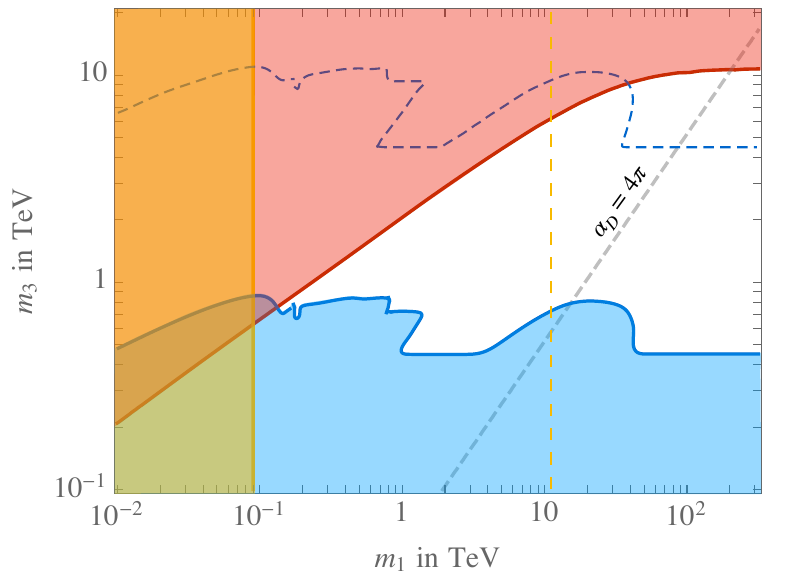
Figure 10 . Same as figure 9 for ε = 10 − 8 , which corresponds to displaced dark photon decays at high-energy colliders.